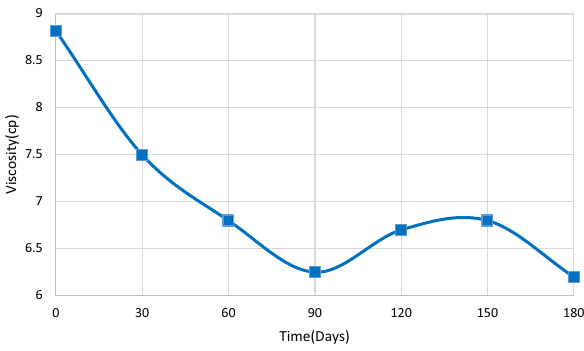
Fig. 8 long time stability of polymer solution during 180 days